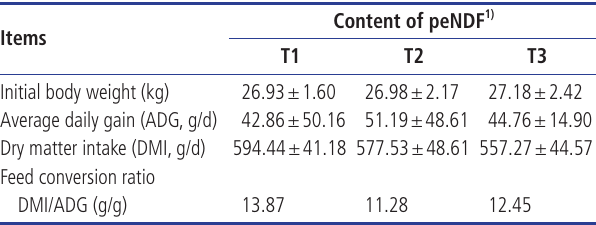
Table 4. Body weight, average daily gain and total dry matter intake in Korean native goats fed TMR feeds with different peNDF contents